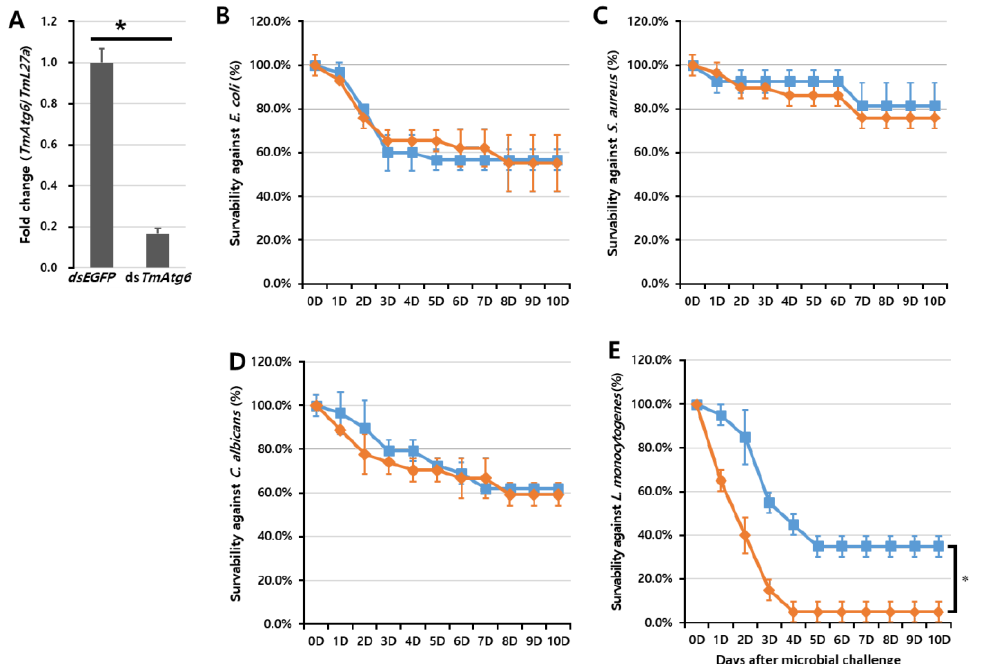
Figure 5. RNA interference (RNAi)-based functional study of TmAtg6 in Tenebrio molitor larvae. Larval survival curves following infection with microorganisms. TmAtg6 knockdown ( A ), E. coli ( B ), S. aureus ( C ), C. albicans ( D ), L. monocytogenes ( E ). * significant at p < 0.05. Results represent the average of three independent replicates with standard error. TmAtg6 gene silencing significantly affected the survivability of T. molitor larvae against L. monocytogenes infection. In contrast, the TmAtg6 gene silencing did not show significant differences in survivability against E. coli, S. aureus, and C. albicans .